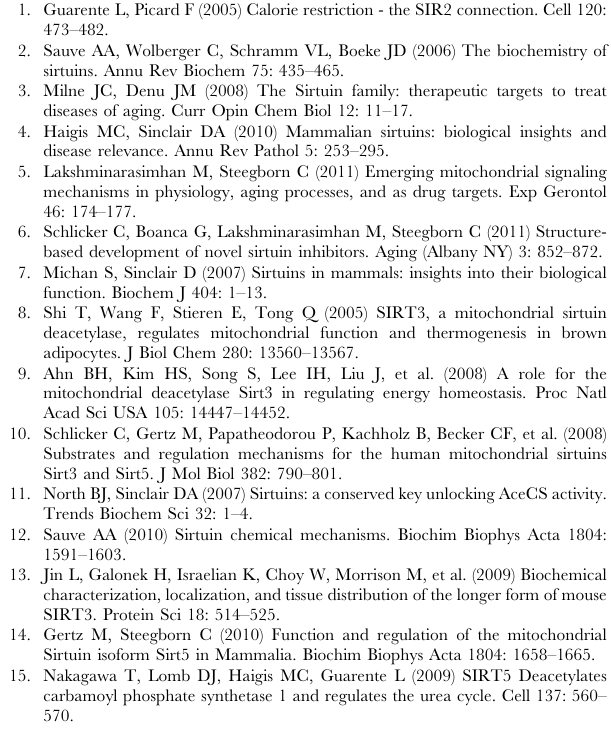
Figure S1 Improved Sirt5 substrates and their binding to Sirt5. Figure S2 Microscale thermophoresis experiments for determination of dissociation constants for NAD + bind- ing to human Sirt3 and Sirt5. Figure S3 Nicotinamide (NAM) dose response curves for various Sirtuins.